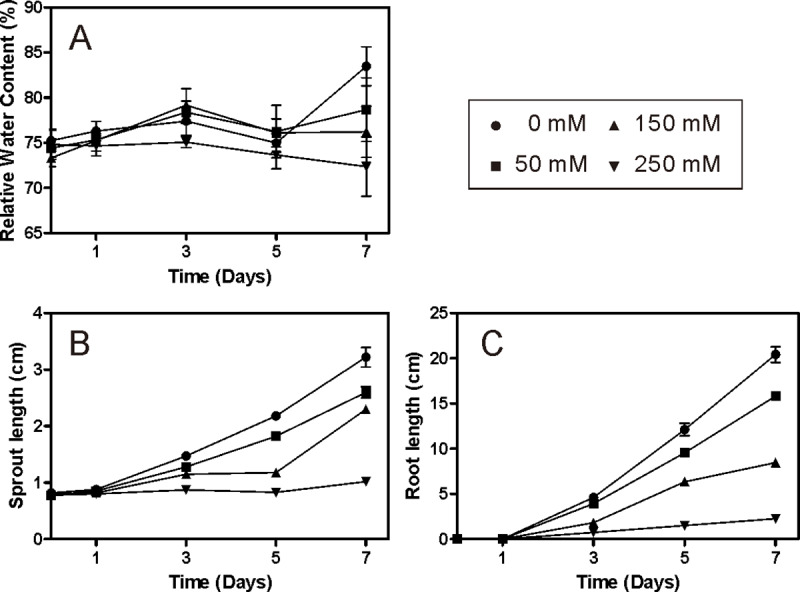
Effect of salt stress on Jerusalem artichoke tuber spouting.(A) Relative water content (RWC) of tuber (%). (B) Sprout length (cm). (C) Root length (cm) (Mean ± SE, n = 4).